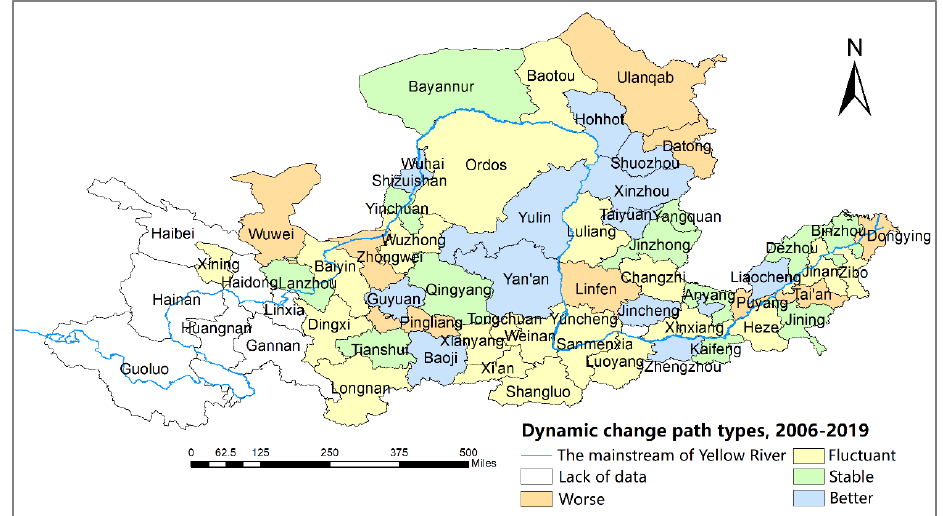
Figure 6. Dynamic change path types for two-dimensional decoupling states, 2006 – 2019.